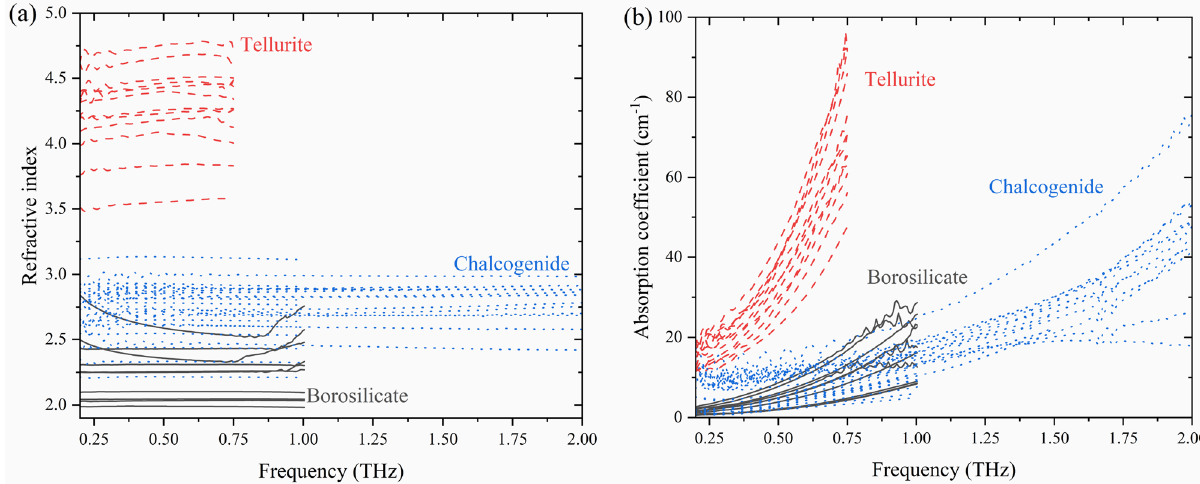
Figure 3. THz ( a ) refractive indices and ( b ) absorption coefficients of all glasses. Oscillations are due to the etalon effect as previously